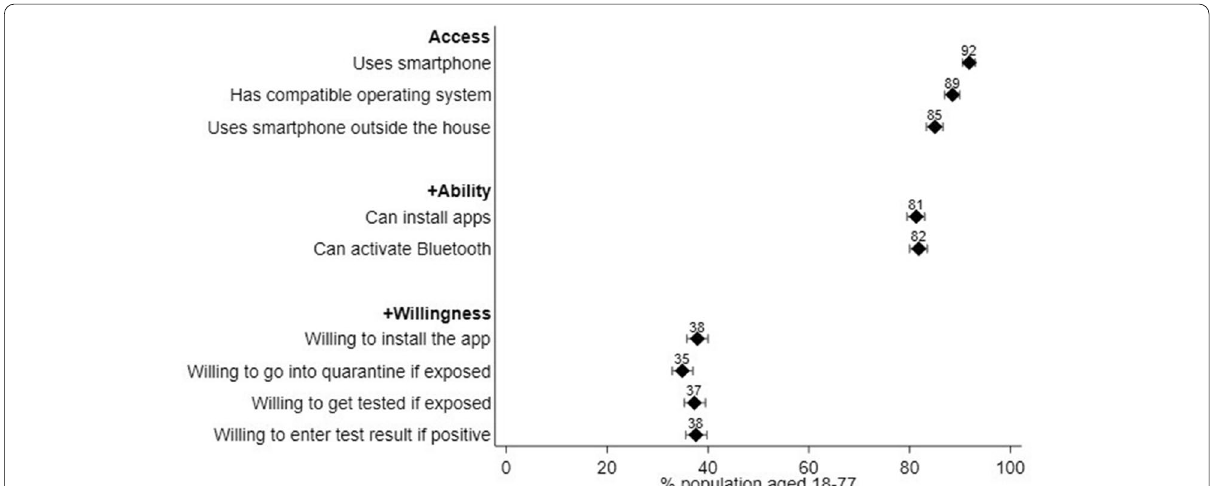
Fig. 1 Predicted COVID-19 tracing app adoption rates by access, ability, and willingness. Error bars represent 95% confidence intervals; ©Annelies G Blom, Alexander Wenz, Carina Cornesse, Tobias Rettig, Marina Fikel, Sabine Friedel, Katja Möhring, Elias Naumann, Maximiliane Reifenscheid, Ulrich Krieger. Originally published in the Journal of Medical Internet Research (http:// www. jmir. org),